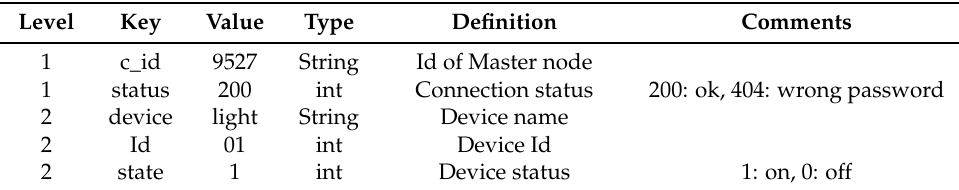
Table 4. Structure of mobile server